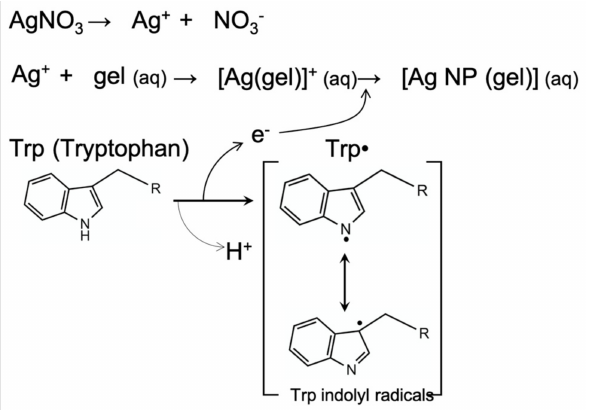
Figure 2. Main schematic of silver nanoparticle generation by